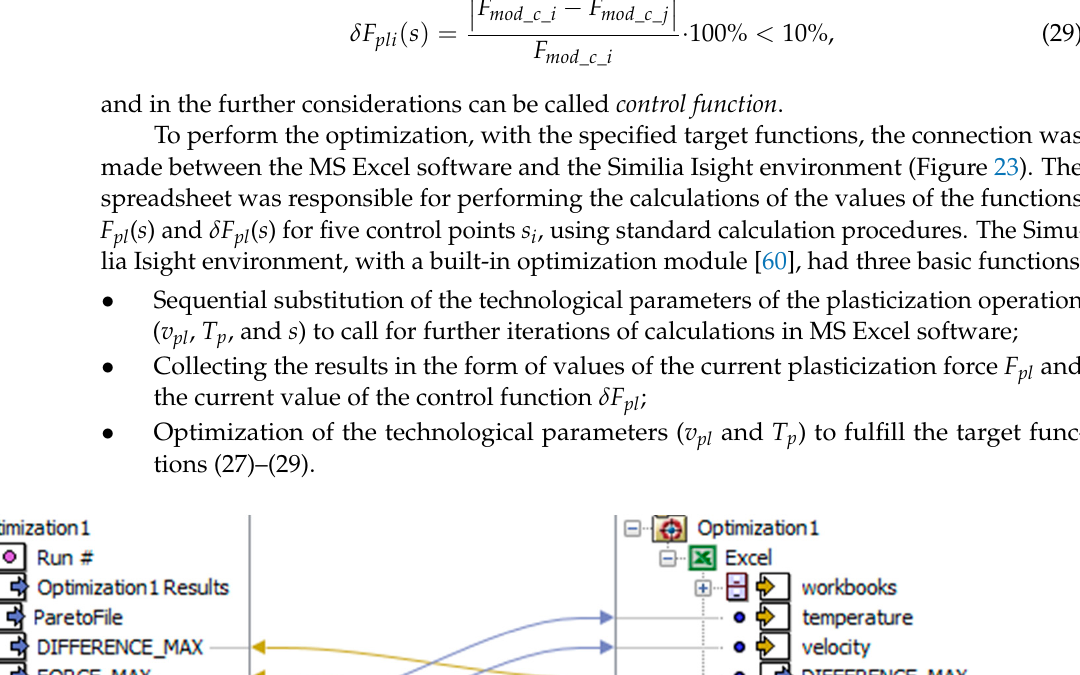
Figure 24. Exemplary map of the calculation points during the plasticization force calculations using the genetic algorithm for the belt with diameter of 18 mm and different plasticization velocity v pl . Figure 25 presents an exemplary surface that is formed by values of the plasticization force F pl . The results are presented in correlation with the technological parameters ( v pl and T p ). This map was obtained on the basis of the model calculations during optimization at individual computing points. The increase in the value of the plasticization force F pl with increasing plasticization velocity v pl and the reduction of the hot plate temperature T p gives an expected effect, which was also confirmed during the experiment (Figure 15). The correlation obtained shows that there was an almost complete coverage of the range in variability of the parameters during calculations. Unfortunately, this type of graph does not show the diversified density of individual computing points (Figure 24). This feature is natural for calculations using a genetic algorithm, due to the densification of the computing points in the area around the optimal solution, with keeping the re- strictions (allowed values of the parameters). Figure 26 shows the exemplary surface formed by the values of the control function δ F pli in correlation with the plasticization parameters ( v pl and T p ). The map is prepared on the basis of the conversion of the developed model at individual computing points during